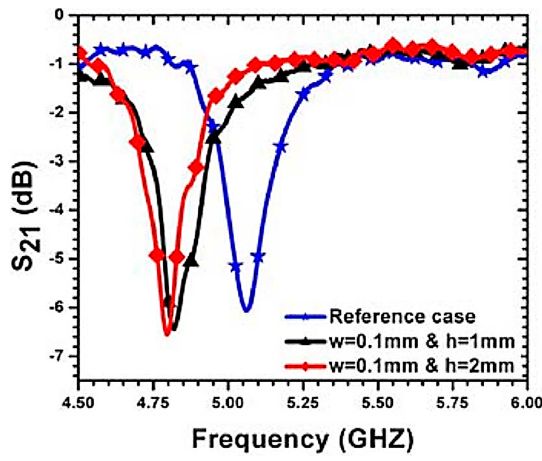
Figure 14. Minimum transmission of the sensor for a crack width ( w ) of 100 μ m as compared to solid aluminum. For Case 1, the crack depth ( h ) is 200 μ m. For Case 2, the crack depth ( h ) is 100 μ m (from [37]; copyright © IEEE 2012; reproduced with permission).